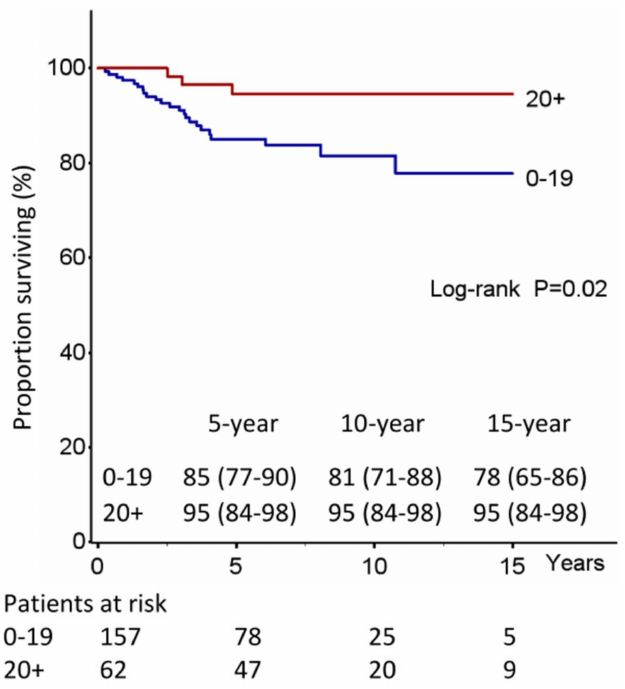
Figure 2. Lung cancer specific survival (CSS) by number of LN removed. Table 2. Factors associated with tumor relapse, cancer specific survival (CSS), and overall survival